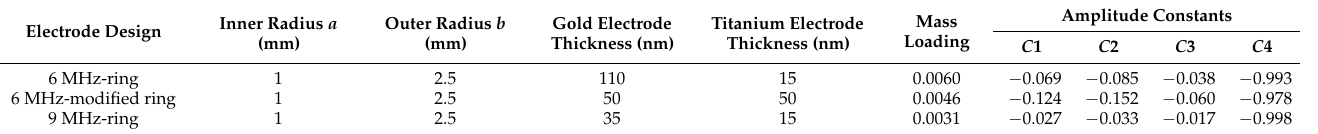
Table 1. A list of optimal results for different electrode configurations as determined by mathematical